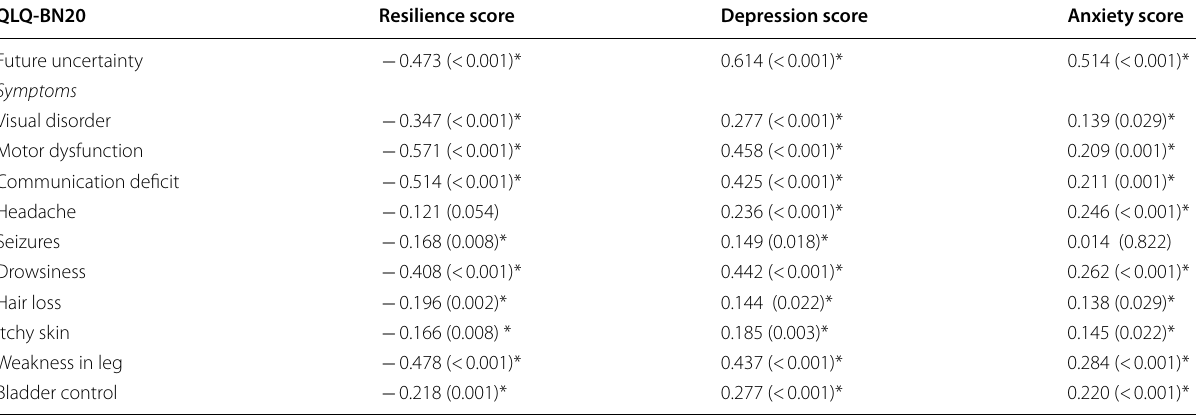
Table 4 Correlation between QLQ-BN20 with resilience, depression and anxiety (construct validity)